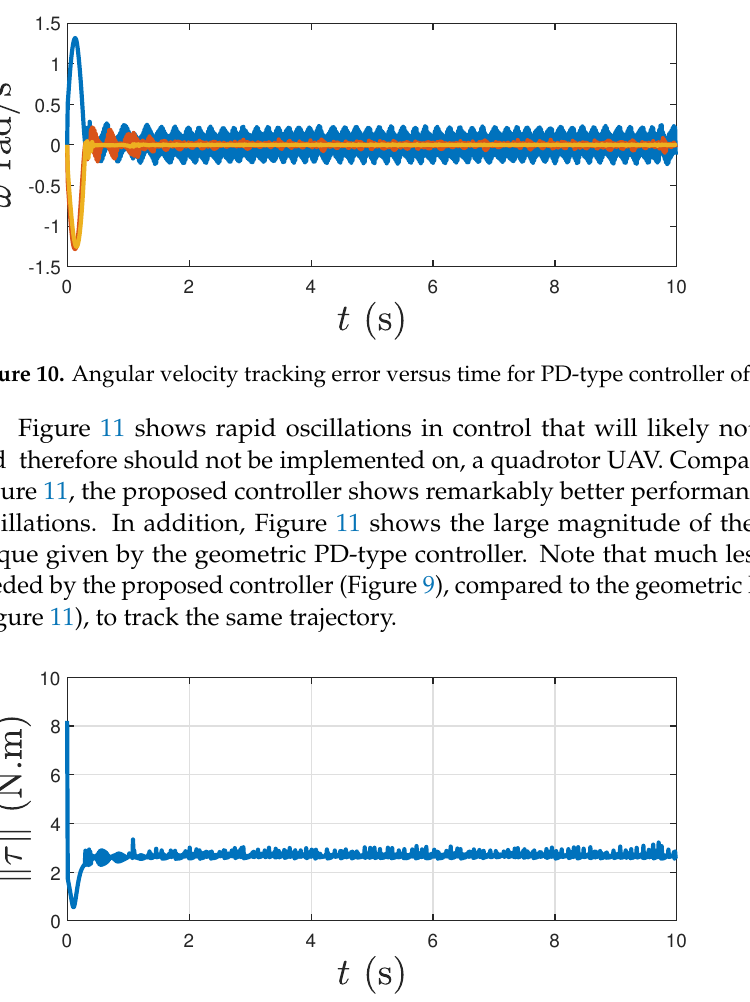
Figure 11. Magnitude of Control torque vs time for PD-type controller of